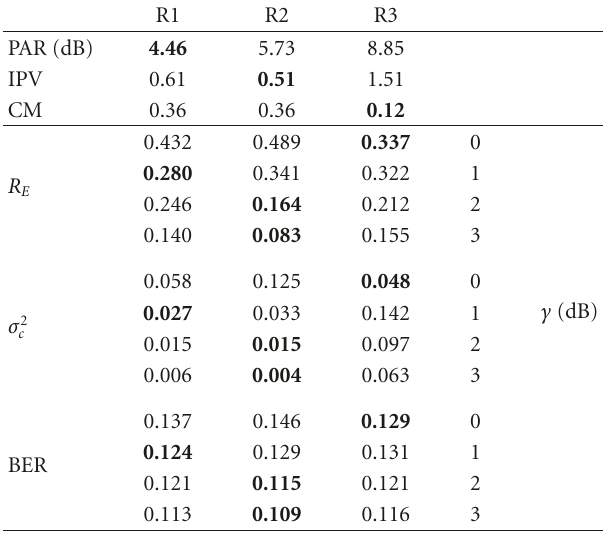
Table 1: Signal Characteristics of R1, R2, and